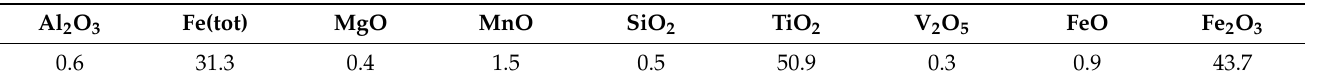
Table 1. Composition (wt.%) of the investigated pellets. Most oxide content levels were based on XRF, while FeO was measured through wet chemistry techniques data from [23]. Fe 2 O 3 was calculated from the other two methods.